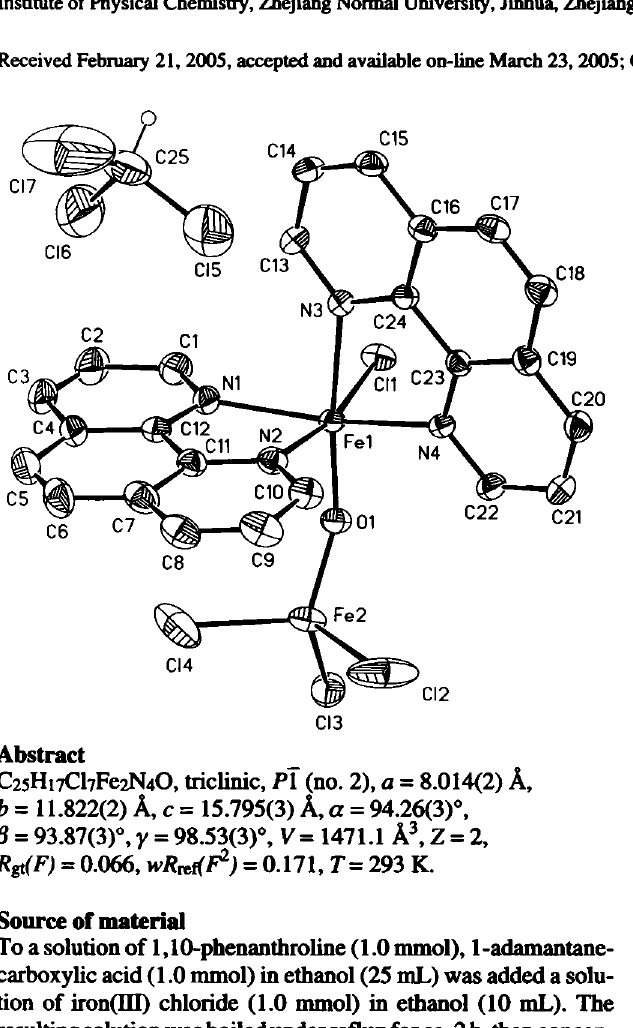
Table 2. Atomic coordinates and displacement parameters (in A 2